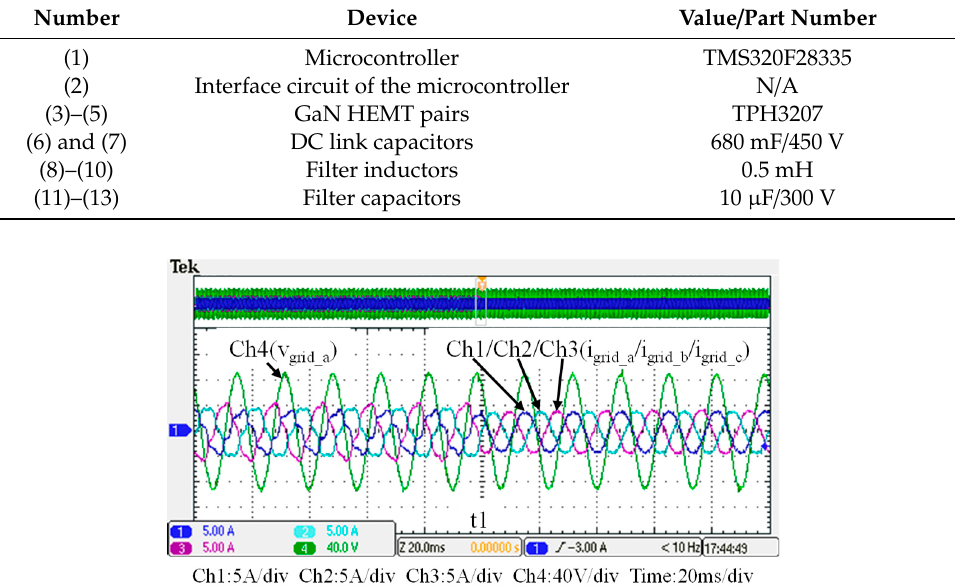
Figure 19. Grid phase-a voltage and three-phase currents (t 0 –t 2 ).